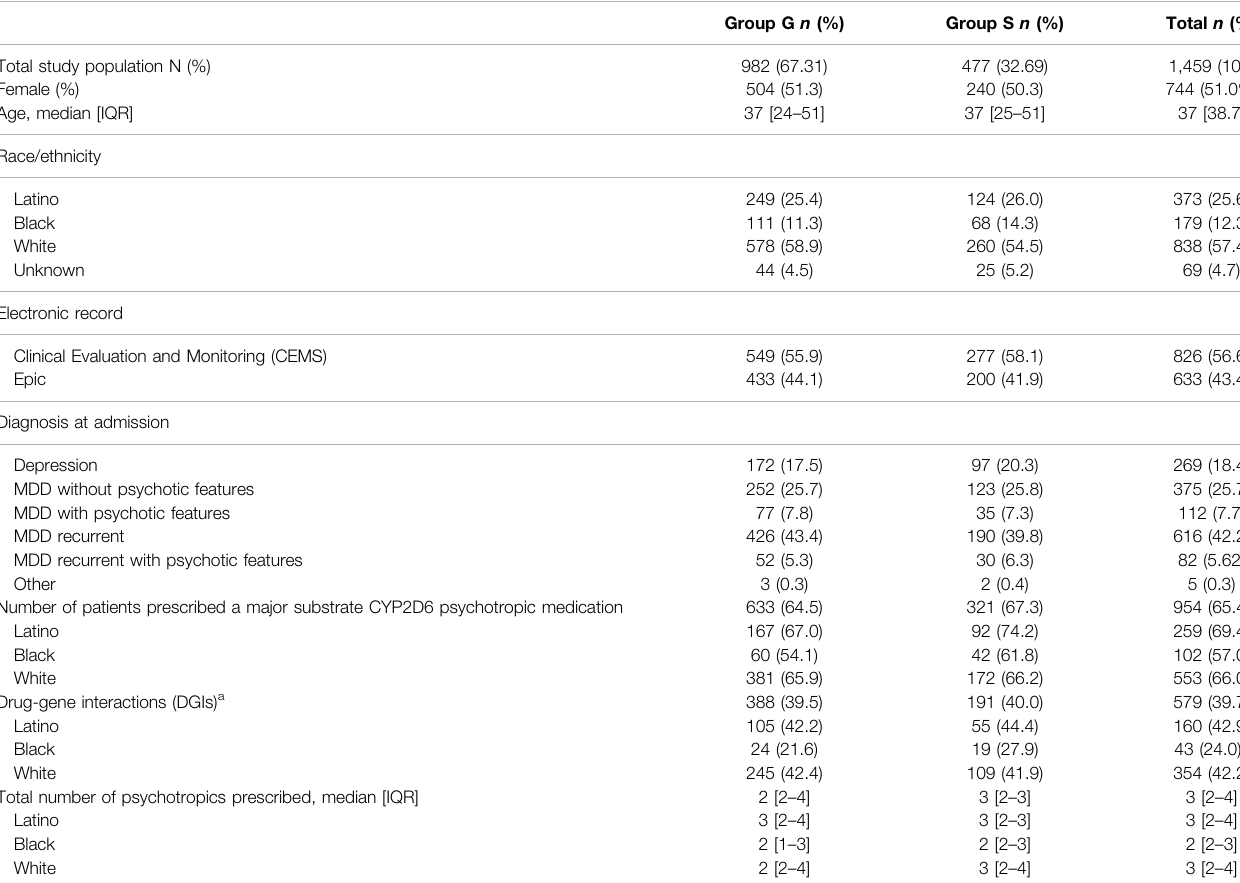
TABLE 1 | Demographics of study